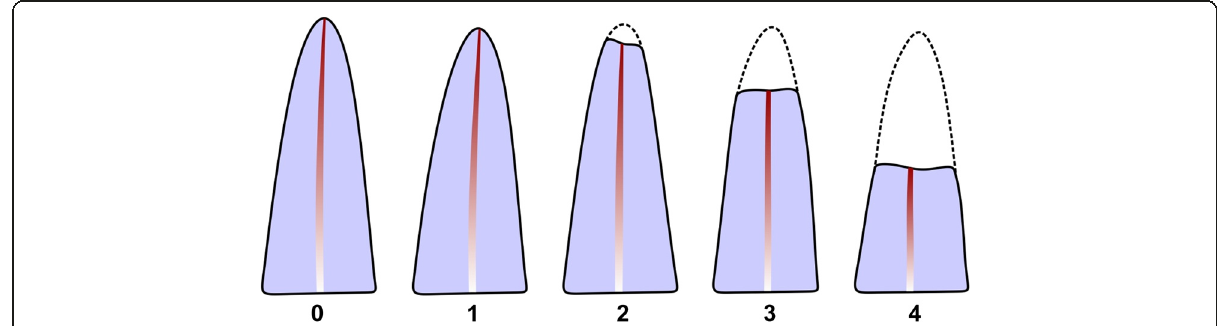
Fig. 2 Ranking levels of the external apical root resorption by Levander and Malmgren [10]. Grade 0 : absence of root resorption; grade 1 : mild resorption, root with its normal length, and only an irregular contour; grade 2 : moderate resorption, small area of root loss with the apex exhibiting an almost straight contour; grade 3 : accentuated resorption, loss of almost one third of root length; and grade 4 : extreme resorption, loss of more than one third of the root